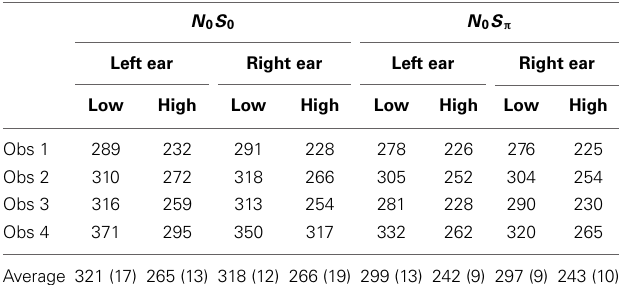
Table 2 | Mean reaction times in ms for the single-target conditions for each subject in the two contexts.